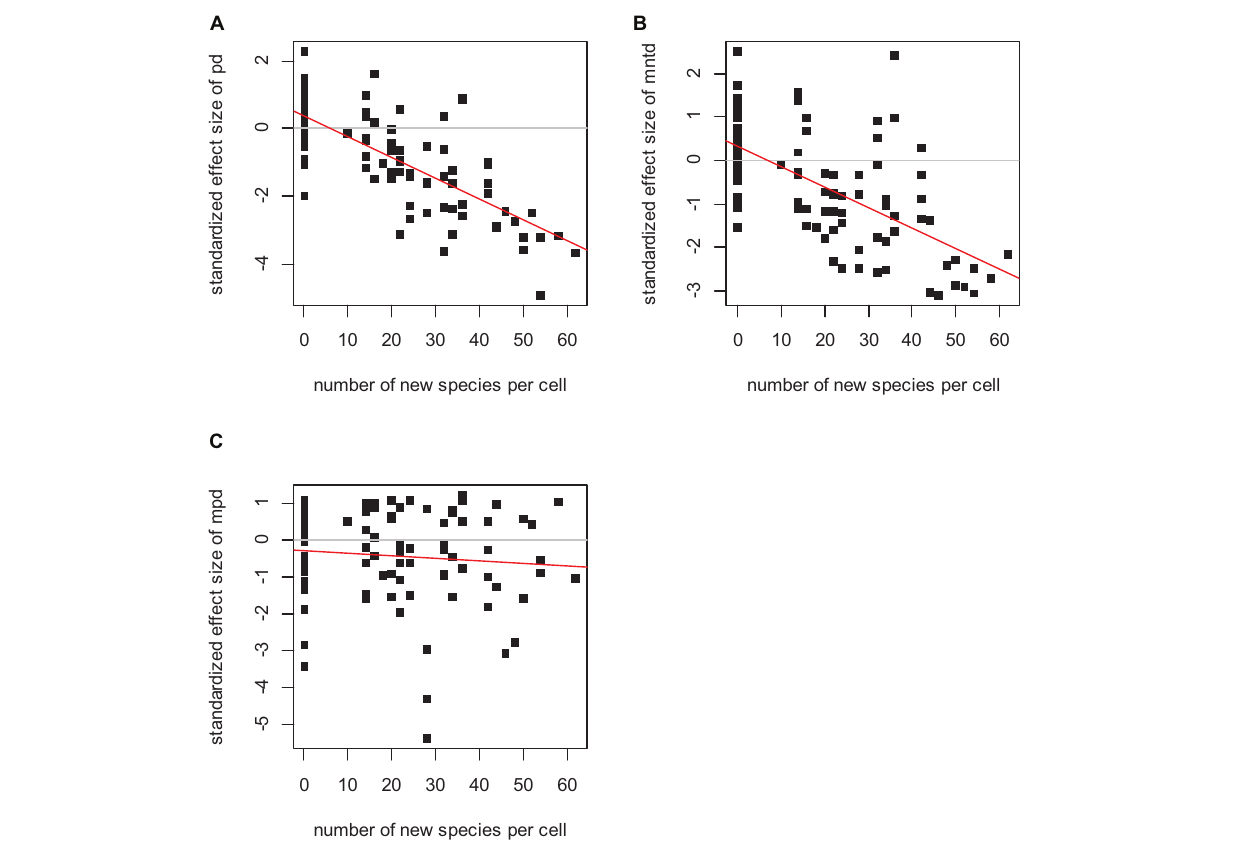
FIGURE 1 | The relationship between the standardized effect size of PD (A) , MNTD (B) , and MPD (C) and the number of speciation events per cell. The linear regression was significant in the case of the standardized effect size of PD ( p < 0.0001, R 2 = 0.67), and of MNTD ( p < 0.0001, R 2 = 0.57), but not significant in the case of MPD ( p = 0.18, R 2 < 0.01). Initial species pool 400 species, initial local species richness 40 species, local population extinction probability 0.1%, no dispersal and sympatric speciation mode.